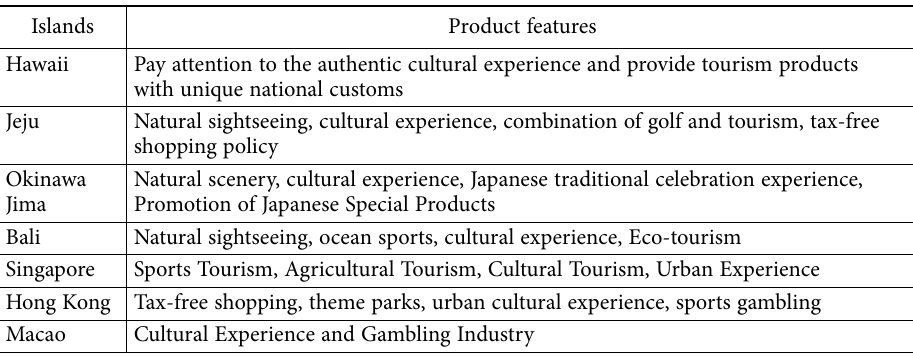
Table 11. Tourism product features of some famous international islands Islands Product